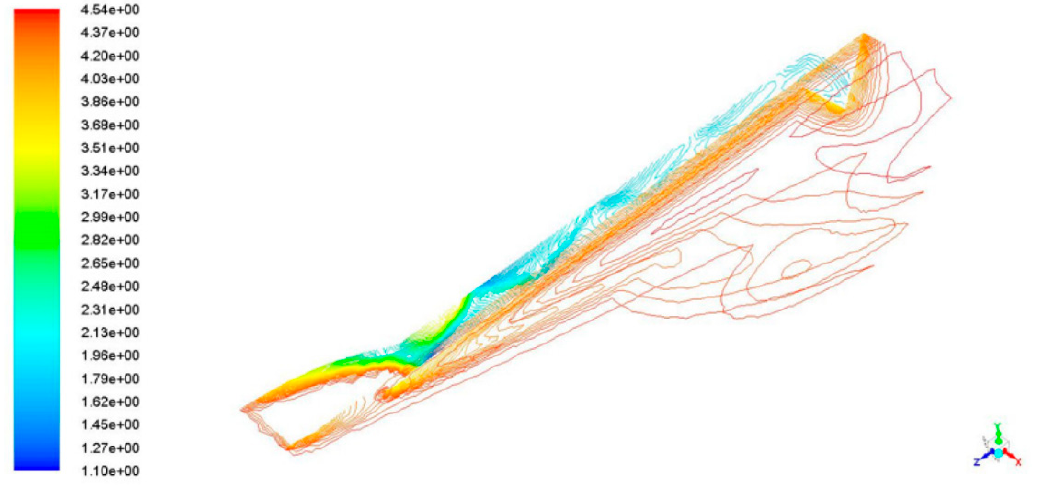
Figure 31. Oblique shock observed at the outward chamfered scramjet wall at Mach 4.5.